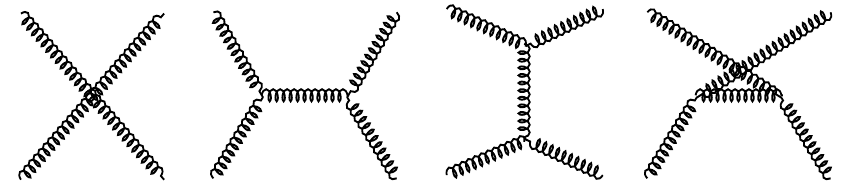
A b → A c A d P P P P